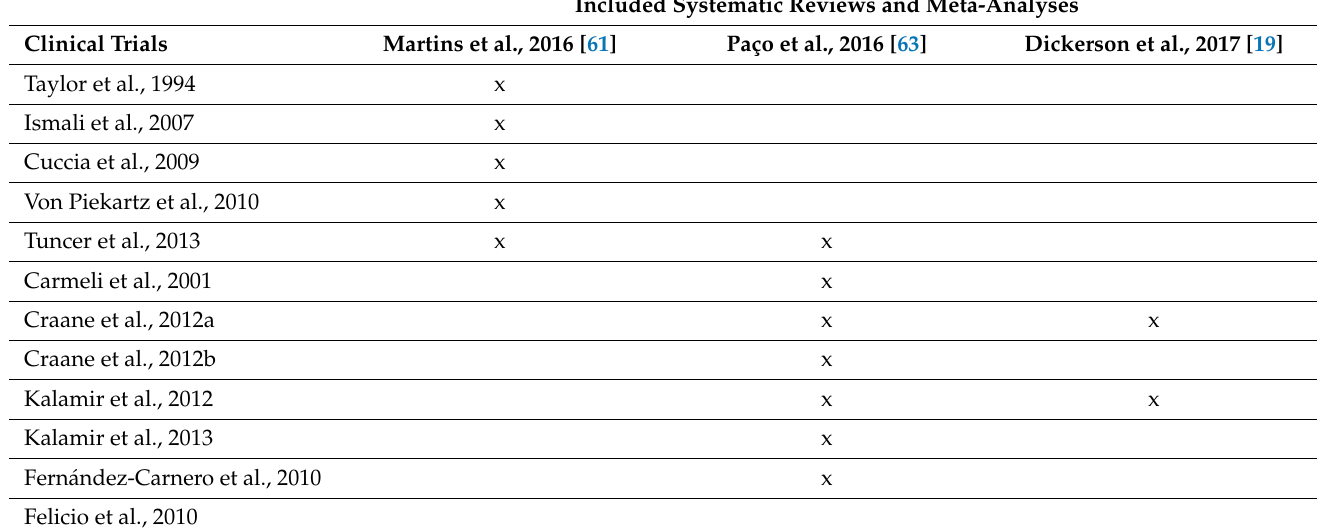
Table A5. Overlap of clinical trials of the MMA of combined manual therapy and therapeutic exercise interventions on mouth opening.